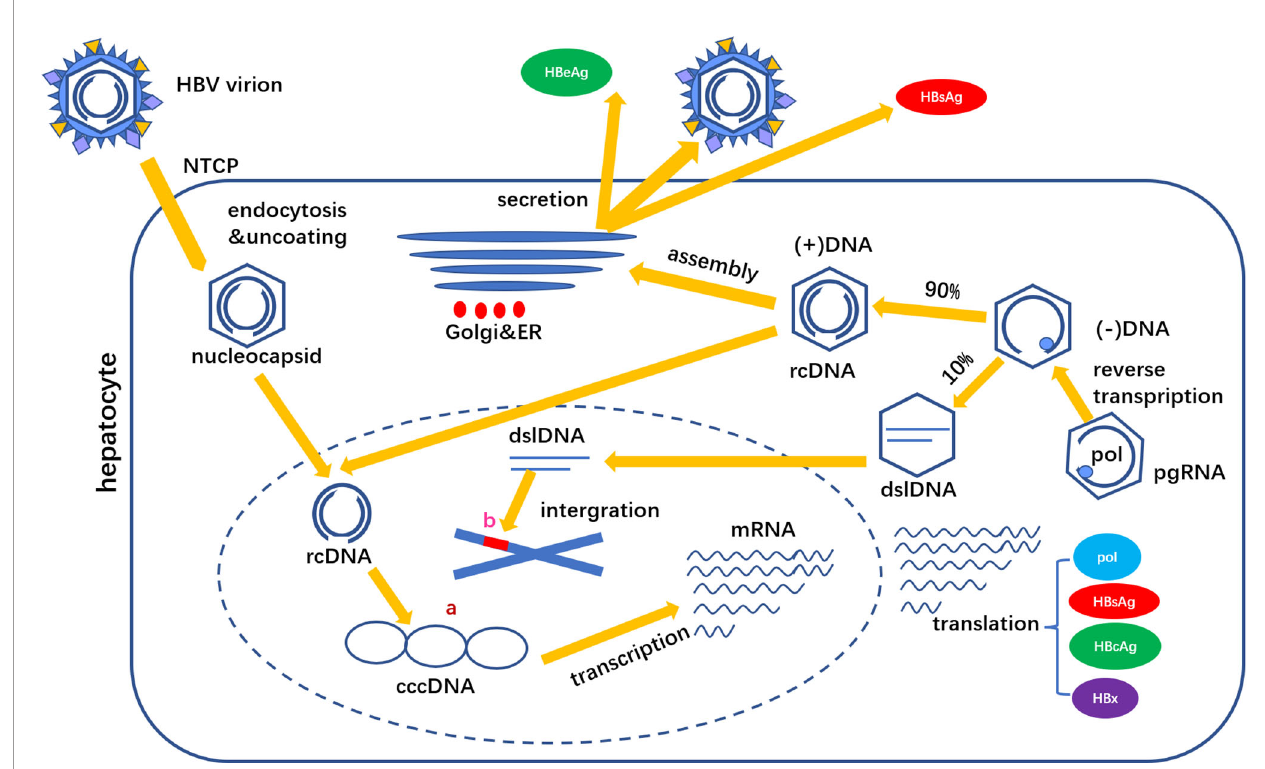
FIGURE 2 | HBsAg is derived from two sources (A) cccDNA and (B) dslDNA. cccDNA is the main source of HBsAg